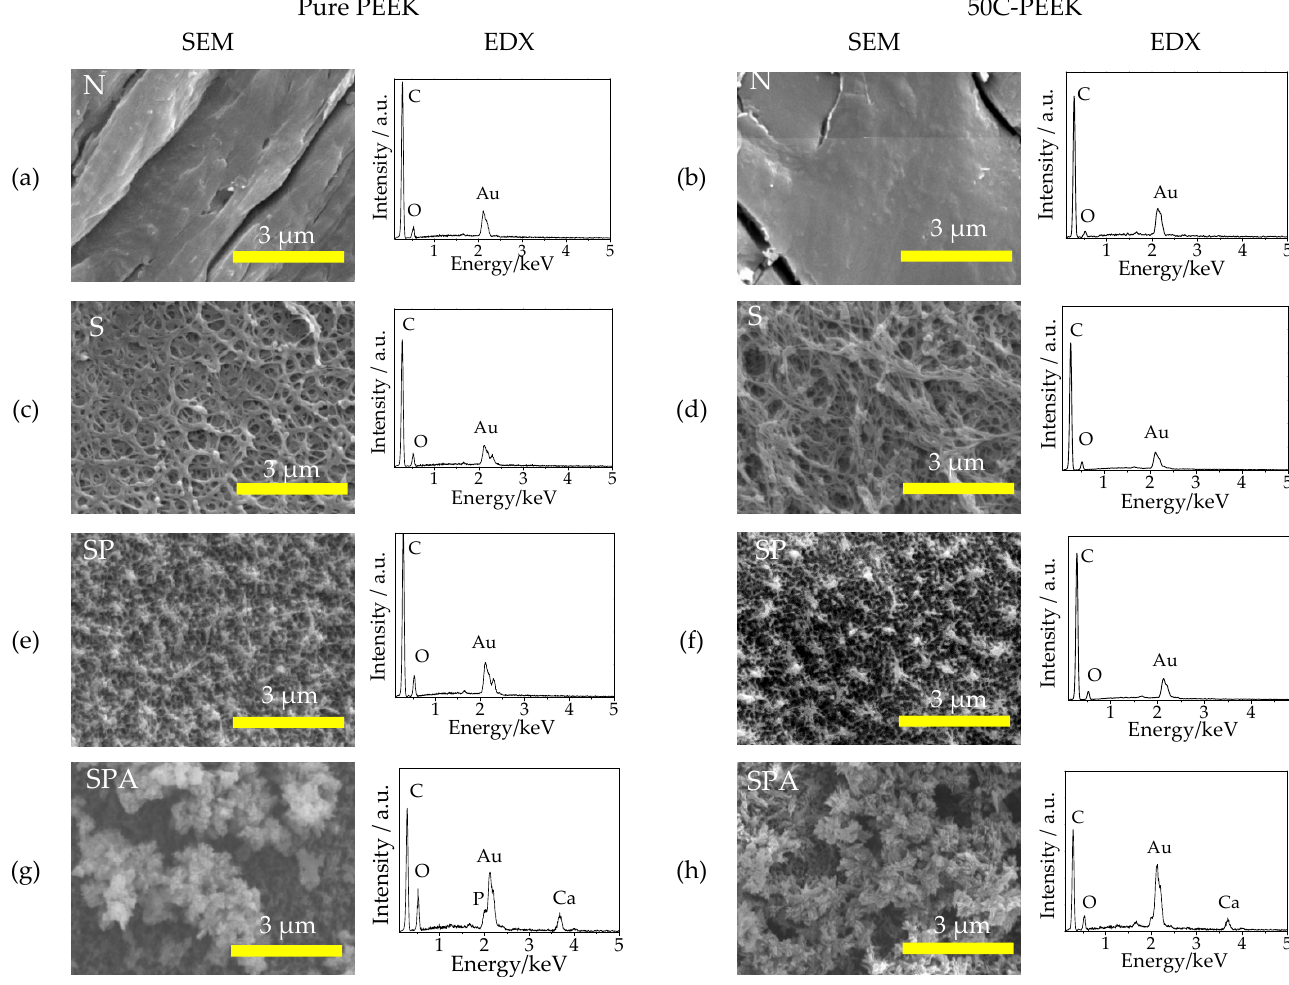
Figure 1. SEM micrographs and EDX profiles on the surfaces of Samples ( a,b ) N: untreated PEEKs, ( c,d ) S: sulfuric acid- treated PEEKs, ( e,f ) SP: sulfuric acid + oxygen plasma-treated PEEKs, and ( g,h ) SPA: sulfuric acid + oxygen plasma + modified-SBF-treated PEEKs for ( a,c,e,g ) pure PEEK and ( b,d,f,h ) 50C-PEEK.